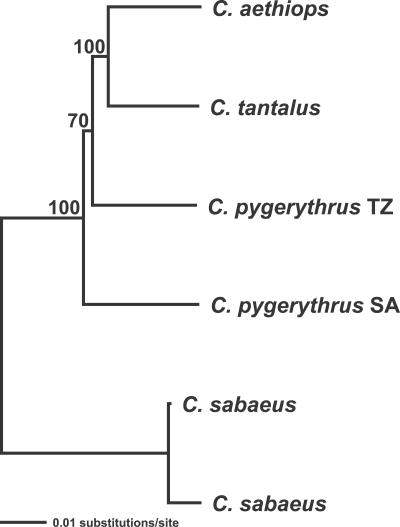
Phylogenetic Relationships among AGM Mitochondrial GenomesML tree is shown with C. sabaeus taxa as an outgroup, although midpoint rooting produced the same rooting pattern. C. pygerythrus were isolated from Tanzania (TZ) and South Africa (SA). ML nonparametric bootstrap support values (>50%) are shown on nodes.